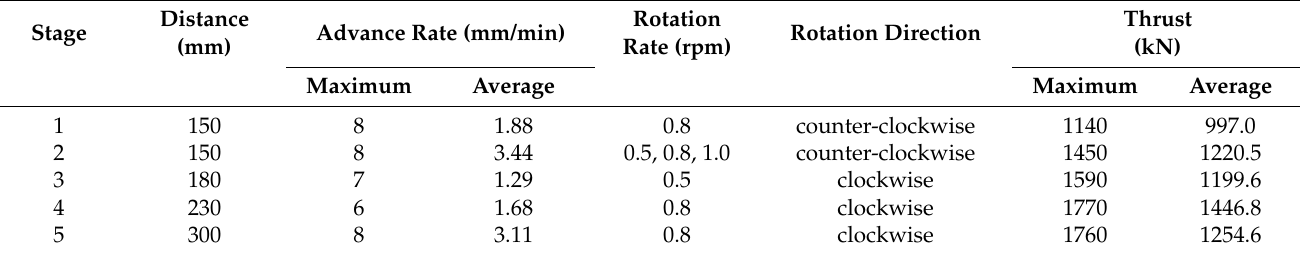
Figure 10. Divided stages of the field test. Table 3. Shield operation parameters in different stages.